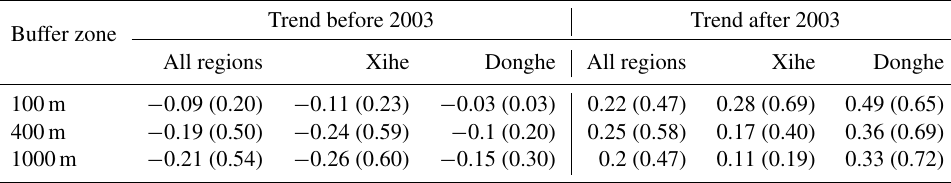
Table 4. Change rates (%) within different buffer zones (coefficient of determination ( R 2 ) indicated in